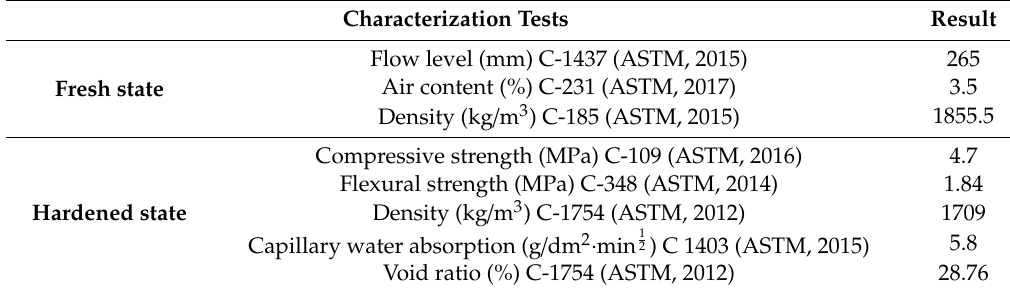
Table 4. Characterization of the mortar for laying and